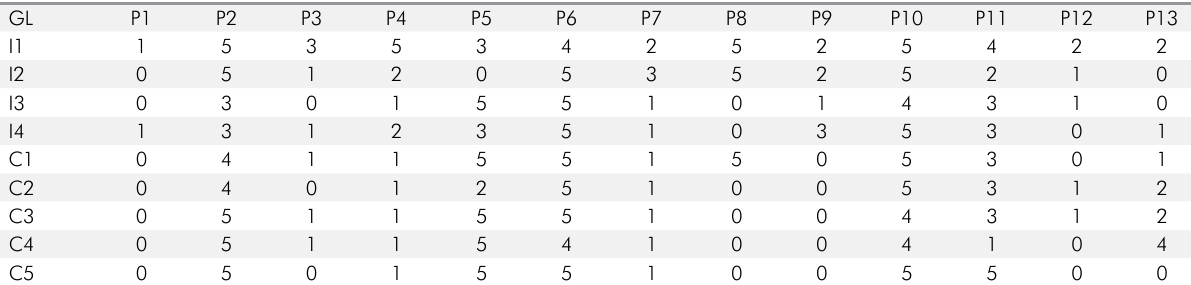
Chart 2. VAS values after each irradiation session and in the five control checkpoints in Laser Group expressed according to the categories of outcome.